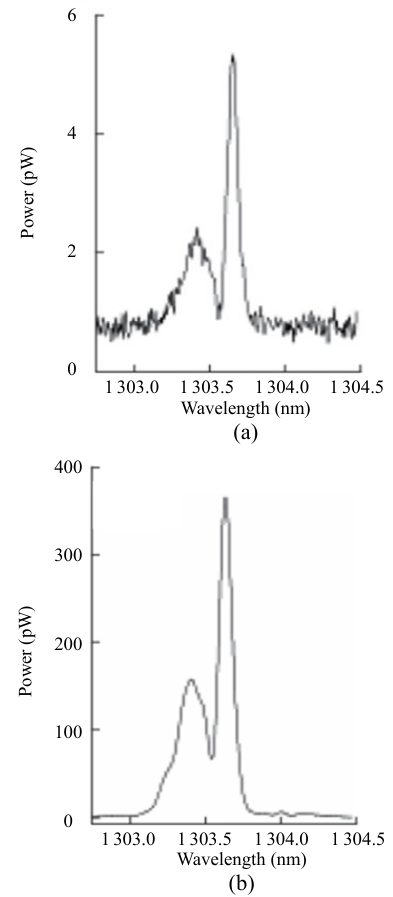
Fig. 2.Re fl ection spectra of (a) the array and (b) the single FBG